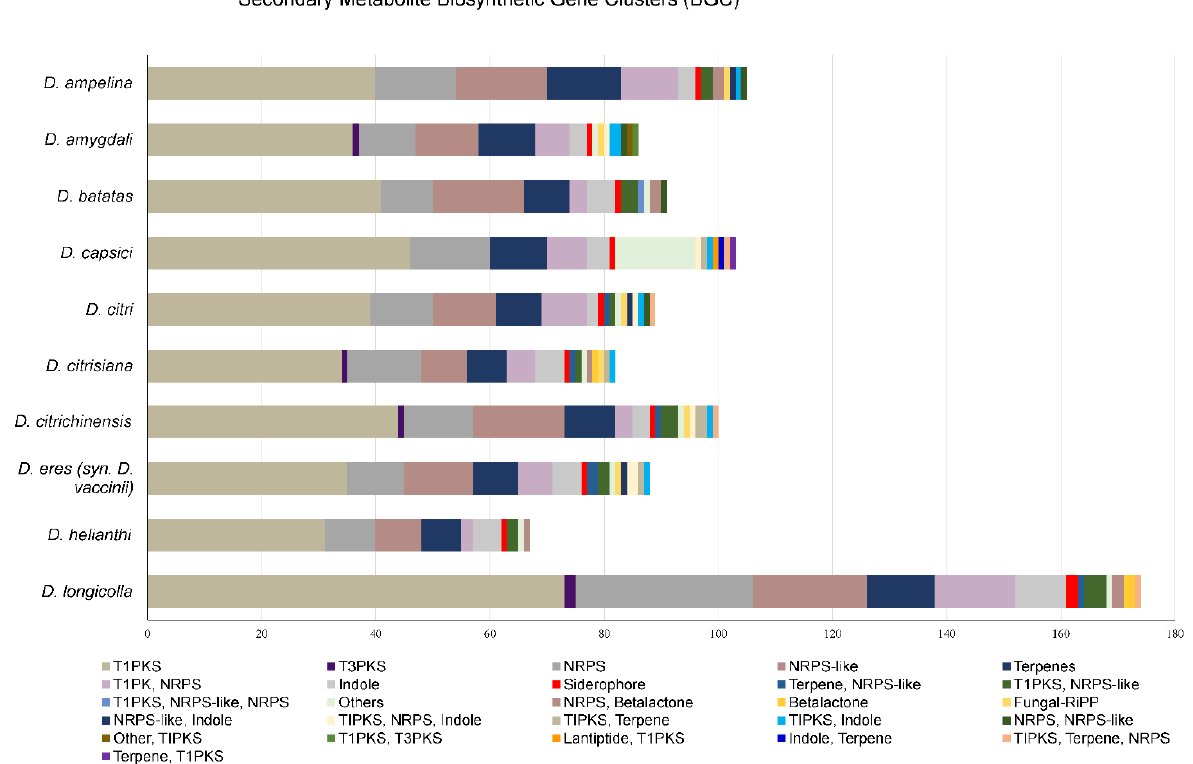
Figure 4. Biosynthetic gene clusters (BGCs) identified in the genomes of Diaporthe analyzed. Diaporthe caulivora BGCs are not included because the genome is not publicly available.